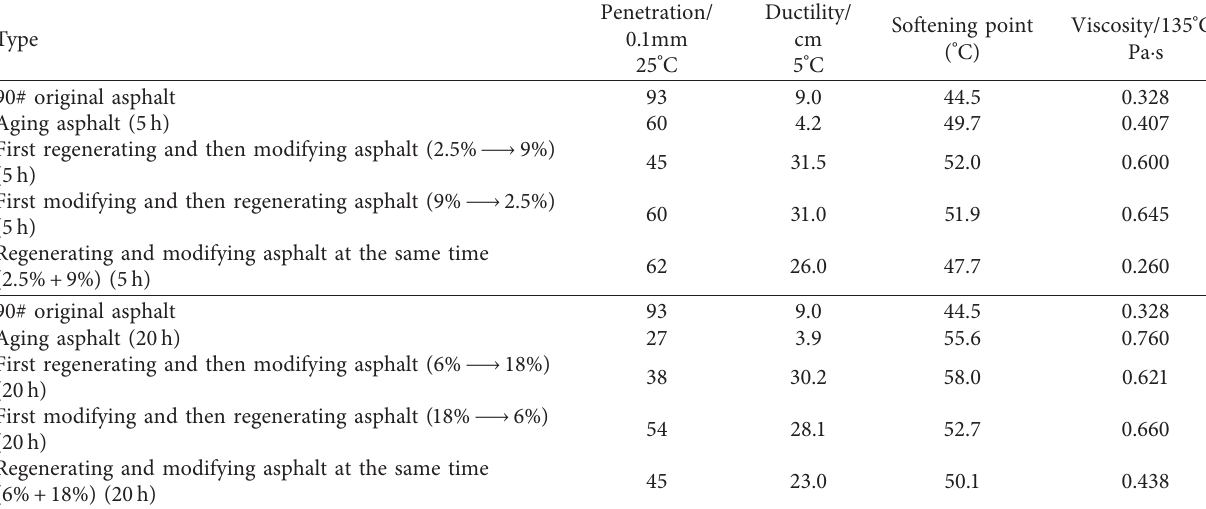
Figure 8: Index relationships of regenerating and modifying test of aging asphalt at the same time. Table 12: Index comparisons of regeneration and modification about aging